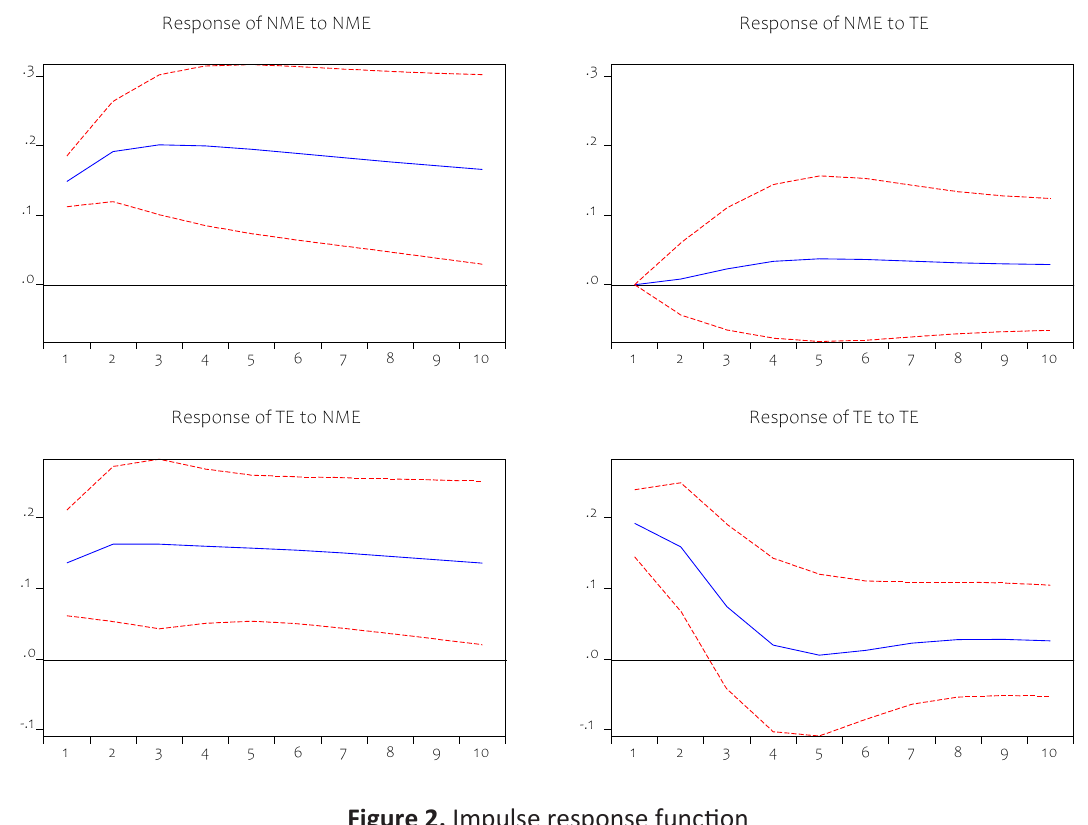
Figure 2. Impulse response function